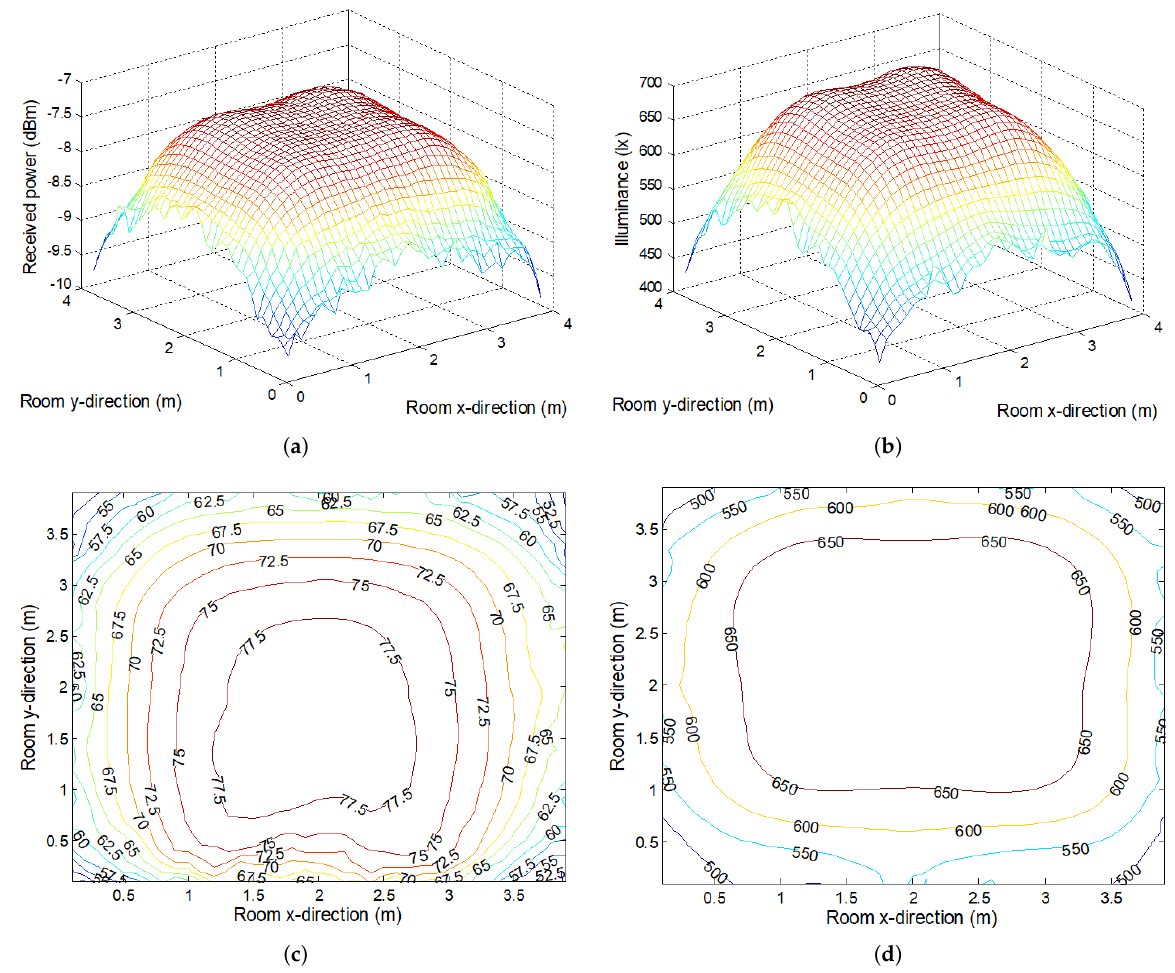
Figure 4. Received power and illuminance at receiver plane for room described in Table 1: ( a ) Power balance. ( b ) Illuminance. ( c ) Contour map of LOS component percentage in the total received power. ( d ) Contour map of illumination